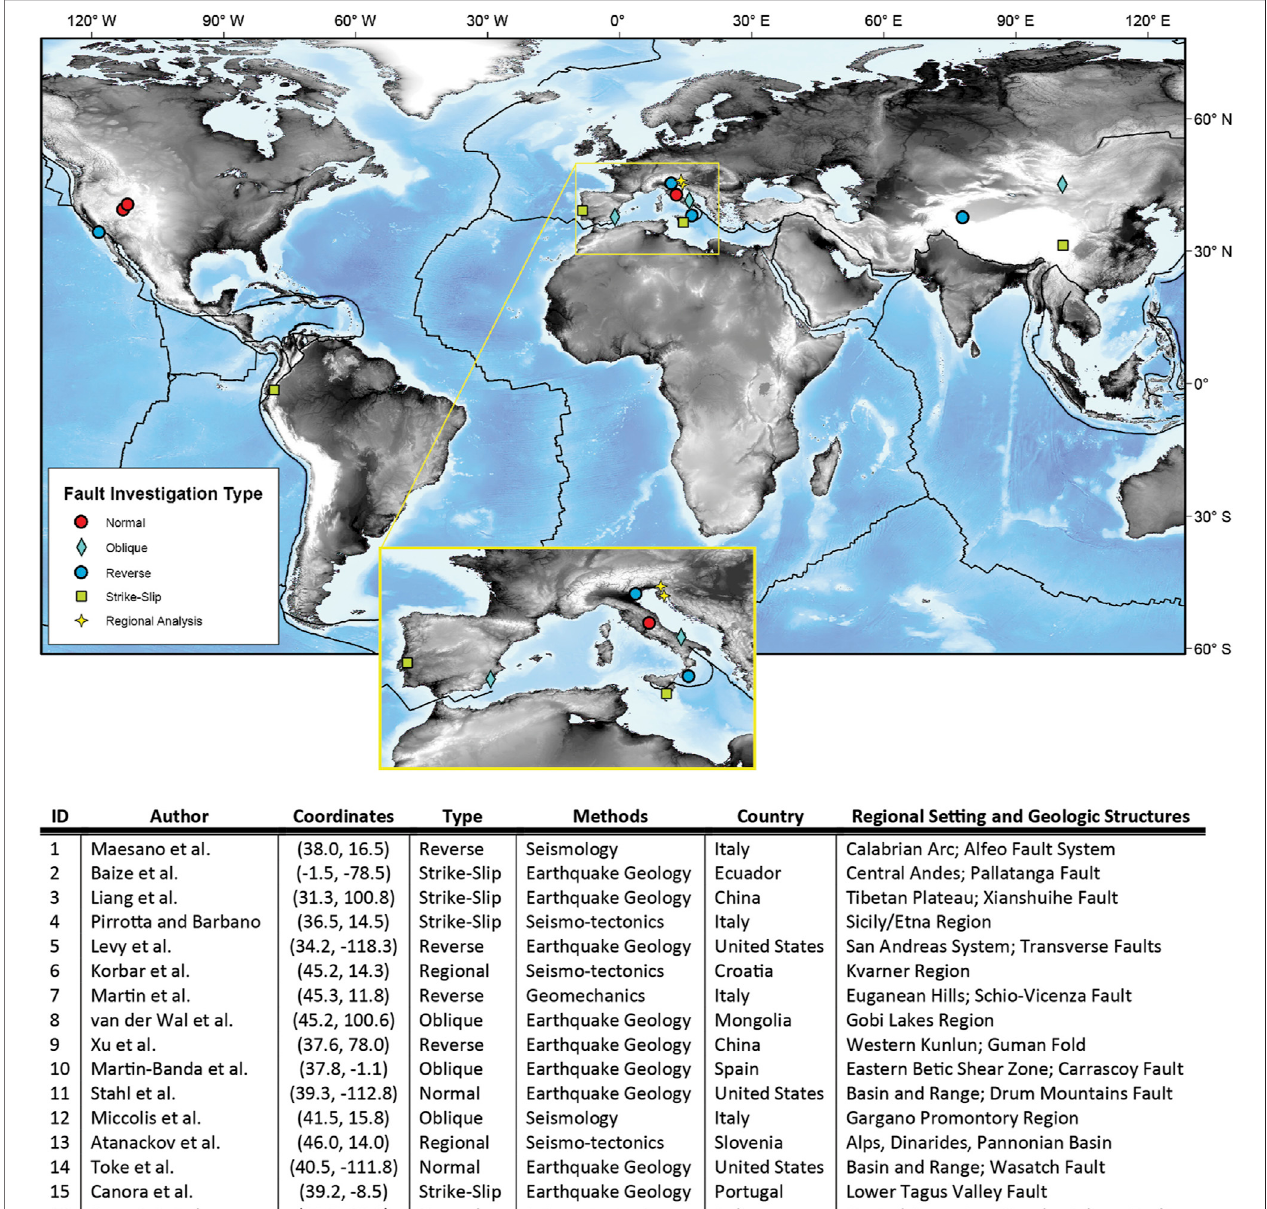
FIGURE 1 | Sixteen contributions were published as a part of this Frontier ’ s in Earth Science Research Topic. These studies sample a range of tectonic regions, styles of faulting, methods, and scales of analysis. The global 30-arc-second Digital Elevation Model is from NOOA (National Center for Environmental Information), at https://www.ngdc.noaa.gov/mgg/global/; tectonic plate boundaries are from PLATES project — UT Institute for Geophysics, at https://ig.utexas.edu/marine-and- tectonics/plates-project/.